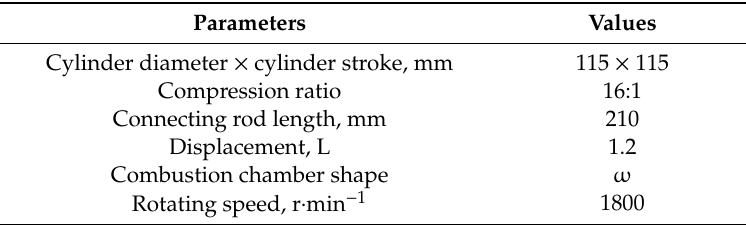
Table 1. Engine structural parameters